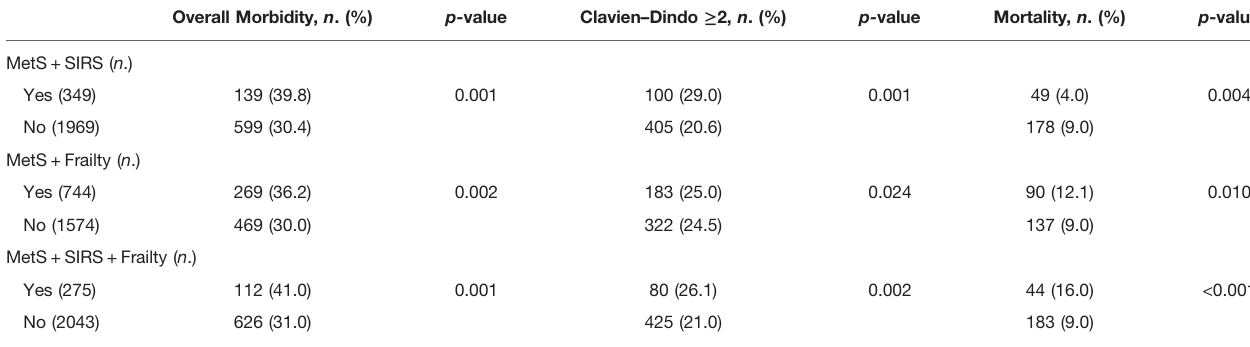
TABLE 3 | Comparison of overall morbidity, major complications, and mortality among patients with MetS, SIRS, and frailty Overall Morbidity, n . (%) p -value Clavien – Dindo ≥ 2, n . (%) p- value Mortality, n . (%) p -value MetS+SIRS ( n